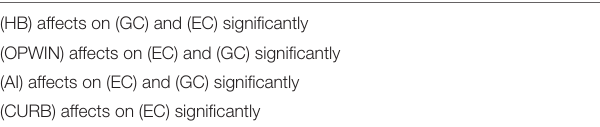
TABLE 5 | Questions table with their latent factor and factor loading measured by running PLS